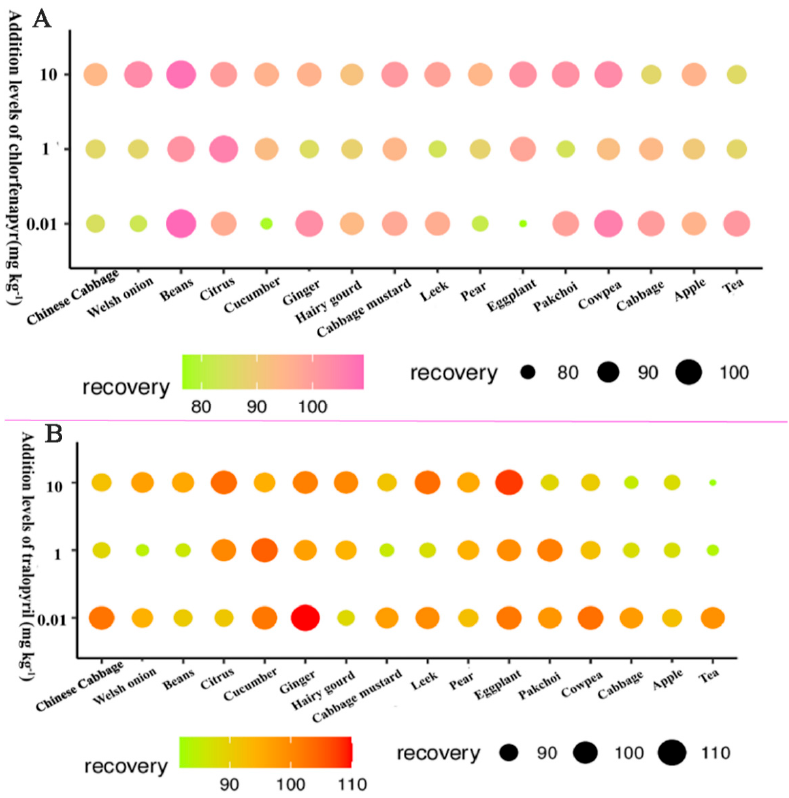
Figure 2. Recoveries of chlorfenapyr ( A ) and tralopyril ( B ) in multiple matrices. Note: the colors and circle sizes both show the amount of